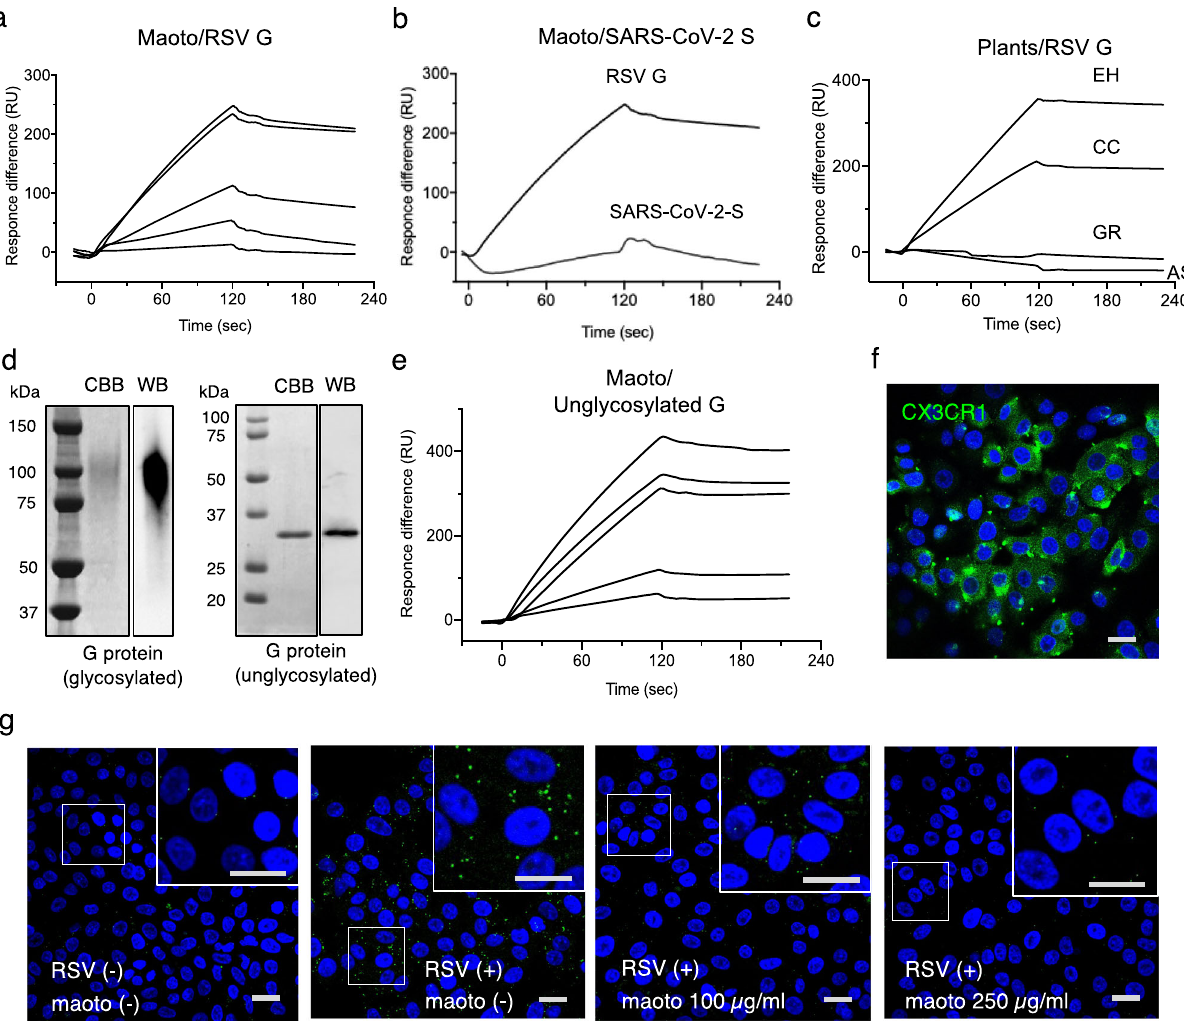
Fig. 3 Speci fi c binding of maoto to the central conserved domain (CCD) of RSV G glycoprotein. a Binding of maoto to RSV G protein immobilized on a sensor chip by surface plasmon resonance (SPR). Five different concentrations (5, 10, 20, 30 and 40 µ g/mL) of maoto were injected. b Selective binding of maoto to RSV G protein. Maoto (40 µ g/mL) was injected to severe acute respiratory syndrome coronavirus-2 (SARS-CoV-2) S protein or RSV G protein immobilized on a sensor chip by SPR. c Binding of Ephedra Herba (EH), Cinnamoni Cortex (CC), Glycyrrhize Radix (GR), and Armeniacae Semen (AS) to RSV G protein immobilized on a sensor chip by SPR. The concentration of each component was 10 µ g/mL. d Molecular weights of glycosylated RSV G protein (left panel) and non-glycosylated RSV G protein (right panel). Glycosylated and non-glycosylated G protein were produced in mammalian cells and Escherichia coli , respectively. The proteins were detected by CBB: Coomassie brilliant blue or WB: Western blotting. e Interaction of maoto with non- glycosylated RSVG protein immobilized on a sensor chip. Binding was assessed by SPR. Five different concentrations (5, 10, 20, 30 and 40 µ g/mL) of maoto were injected. f Expression of CX3CR1 on A549 cells visualized by confocal microscopy (green foci). The horizontal bar indicates 20 µ m. g Inhibition of RSV attachment to CX3CR1 by maoto. RSV (moi 10) was allowed to attach to A549 cells on ice in the presence or absence of maoto. Binding of RSV G protein to CX3CR1 was examined using a proximity ligation assay (PLA). Green foci on cultured cells indicate the PLA probes. f , g Scale bars indicate 20 µ